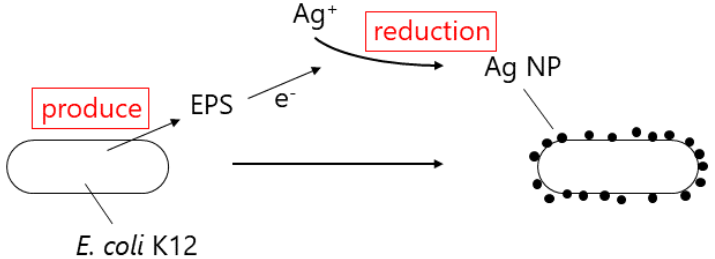
Figure 5. The mechanism of Ag NPs synthesis by E. coli K12. Extracellular polymeric substances (EPS) produced by the cell reduced Ag ion and synthesized Ag NPs.